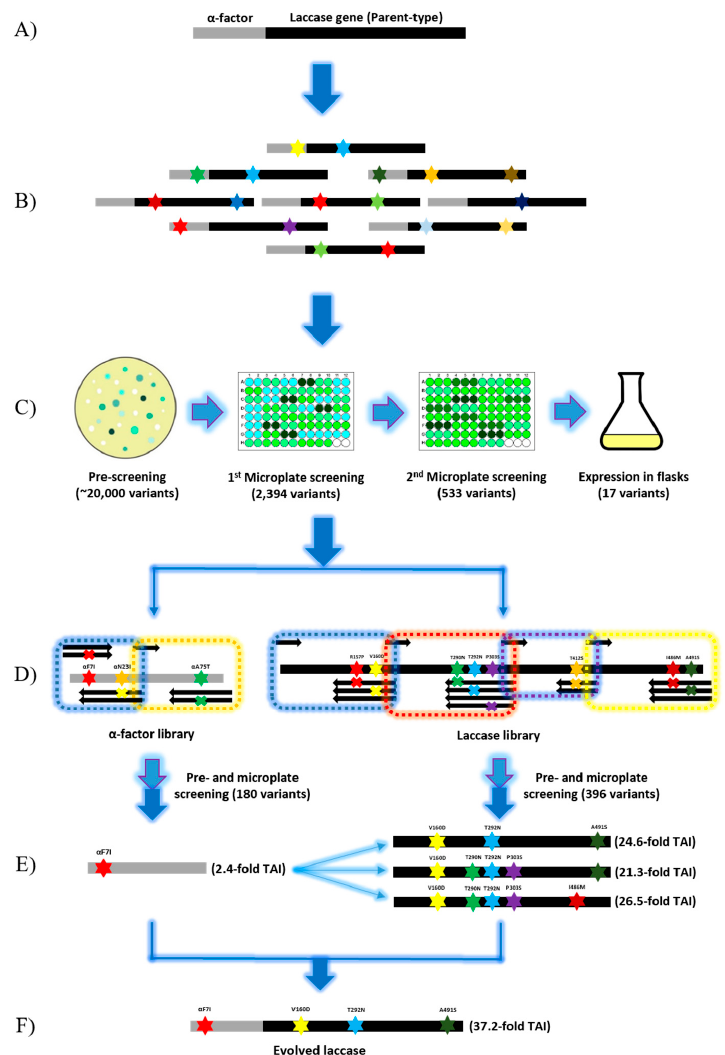
Figure 1. Schematic presentation of laccase directed evolution by random mutagenesis and in vivo assembly in S. cerevisiae . ( A ) Generation of the parent-type laccase gene ( α lacA ) by replacing the original laccase signal peptide sequence with α -factor prepro-leader. ( B ) Generation of the mutagenic library of α lacA by error-prone PCR using the GeneMorph II Random Mutagenesis kit at a mutation rate of between 0 to 4.5 mutations per 1000 bp. Stars in different colors represent mutations. ( C ) High throughput screening of the mutagenic library of α lacA . Light blue arrows represent inoculation. White, light green, and dark green dots on agar plates respectively represent transformants without laccase activity, with low activity and high activity. ( D ) In vivo assembly of α -factor library and laccase library separately in S. cerevisiae . Dotted boxes in different colors represent DNA fragments amplified by using different degenerate primers. ( E ) Identification of the best mutation combinations for each library. Light blue fork represents combination of the evolved α -factor and laccase mutants. ( F ) Confirmation of the best variant of α lacA